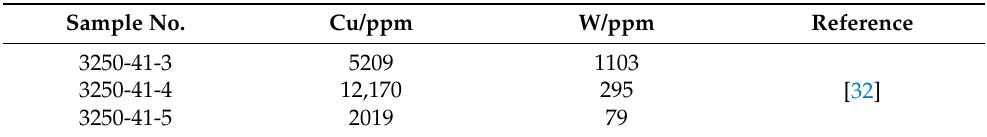
Figure 19. The photos of tungsten mineralization in the Yangla Cu-W polymetallic deposit. ( a ) and ( b ) the photographs of tungsten ore body with the host second sequence of Linong Formation; ( c ) and ( d ) the photographs of hand specimen of scheelite with the host marble. Table 4. The metallogenic elements (Cu and W) concentrations of quartz diorite in the Yangla Cu-W polymetallic